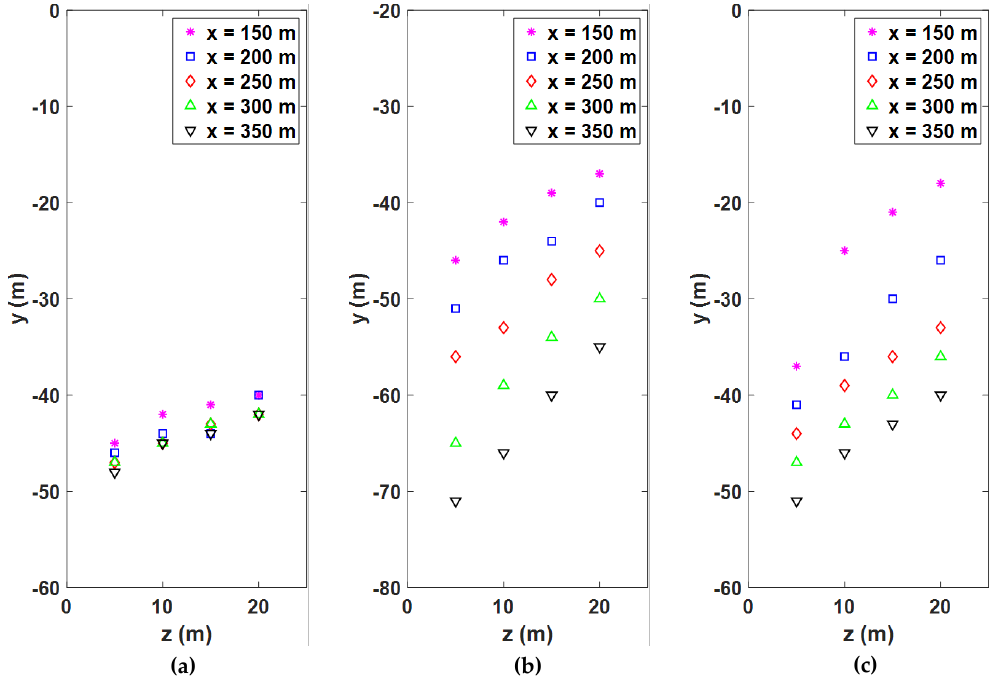
Figure 9. Variation of maximum along-wind velocity deficits in the vertical direction: ( a ) 22.5 ° ; ( b ) 45 ° ; ( c ) 67.5 ° .